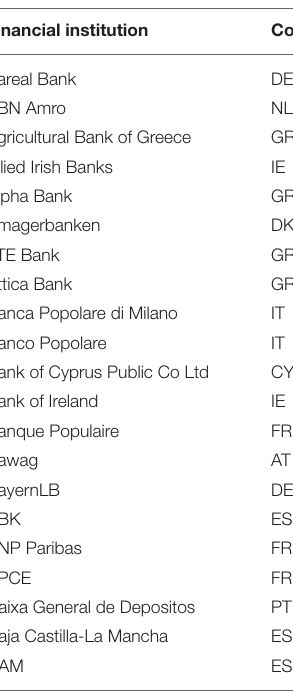
TABLE 3 | List of considered financial